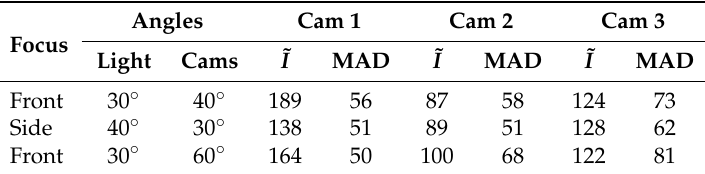
Table A4. Evaluation of the orientation of the light sources.